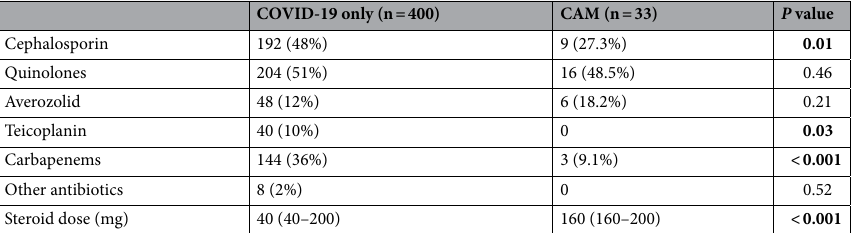
COVID-19 only (n =